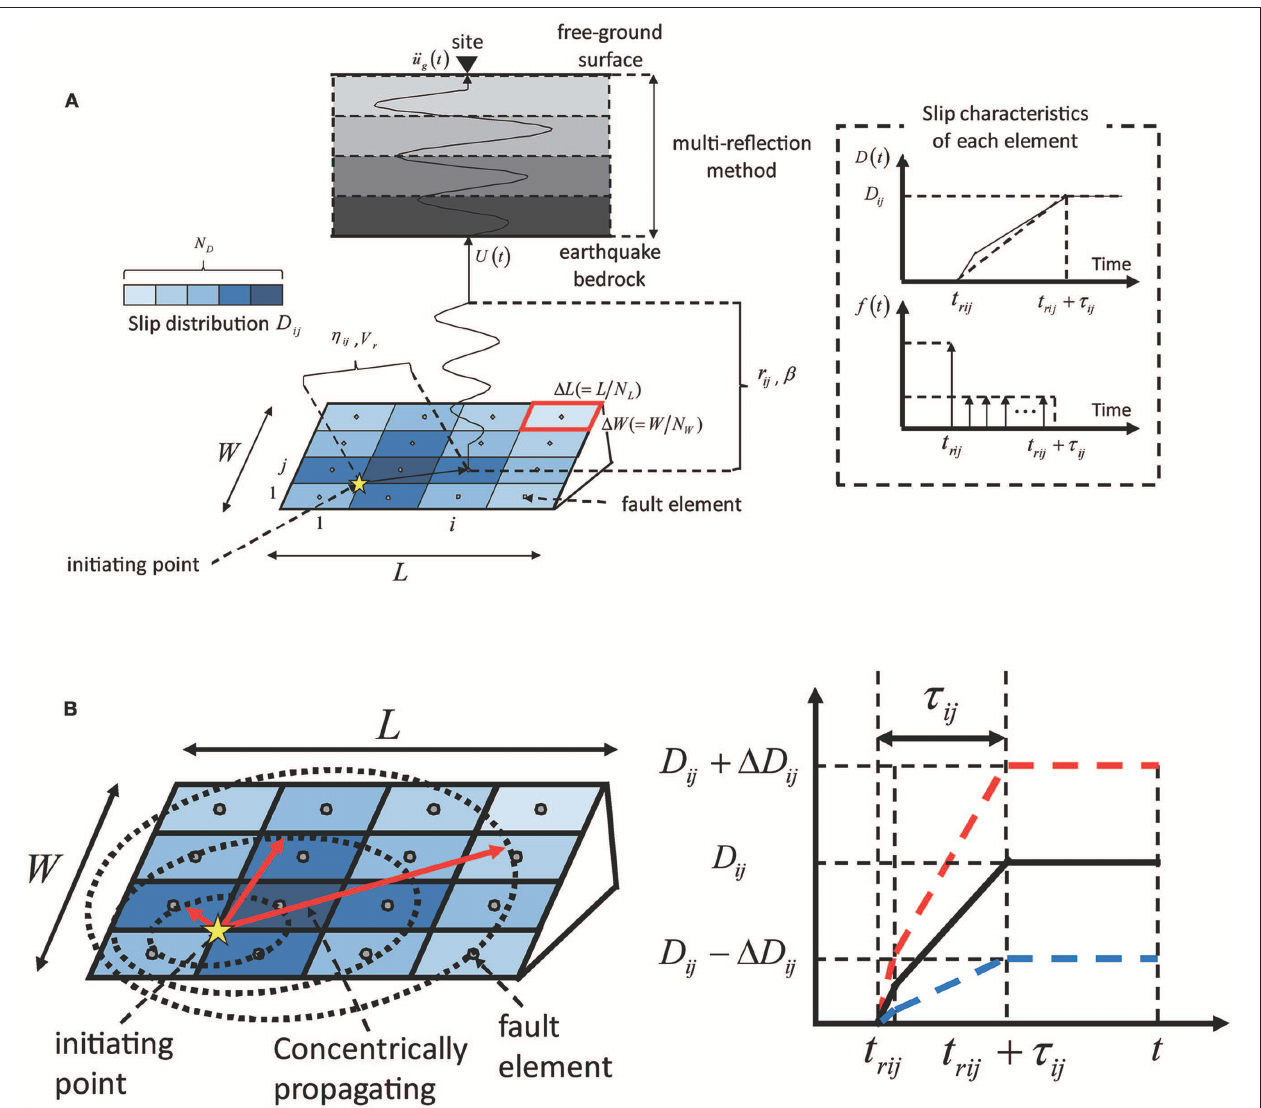
FIGURE 1 | Ground motion generation method and fault slip model. (A) Concept of stochastic Green’s function method used in the present paper. (B) Concentrically propagating slip model and uncertainty in slip quantity.